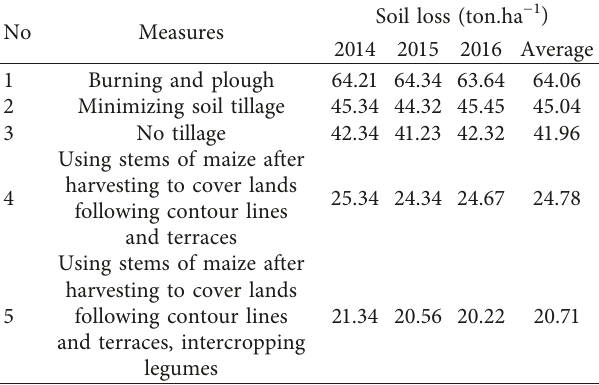
Table 7: Soil loss caused by measures cultivating maize in Co